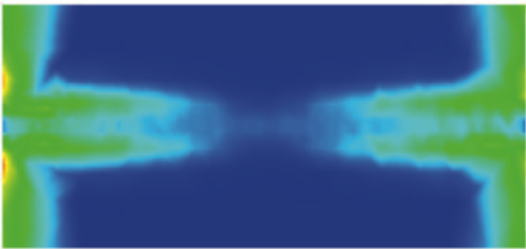
Figure 8: Current distribution in the model.